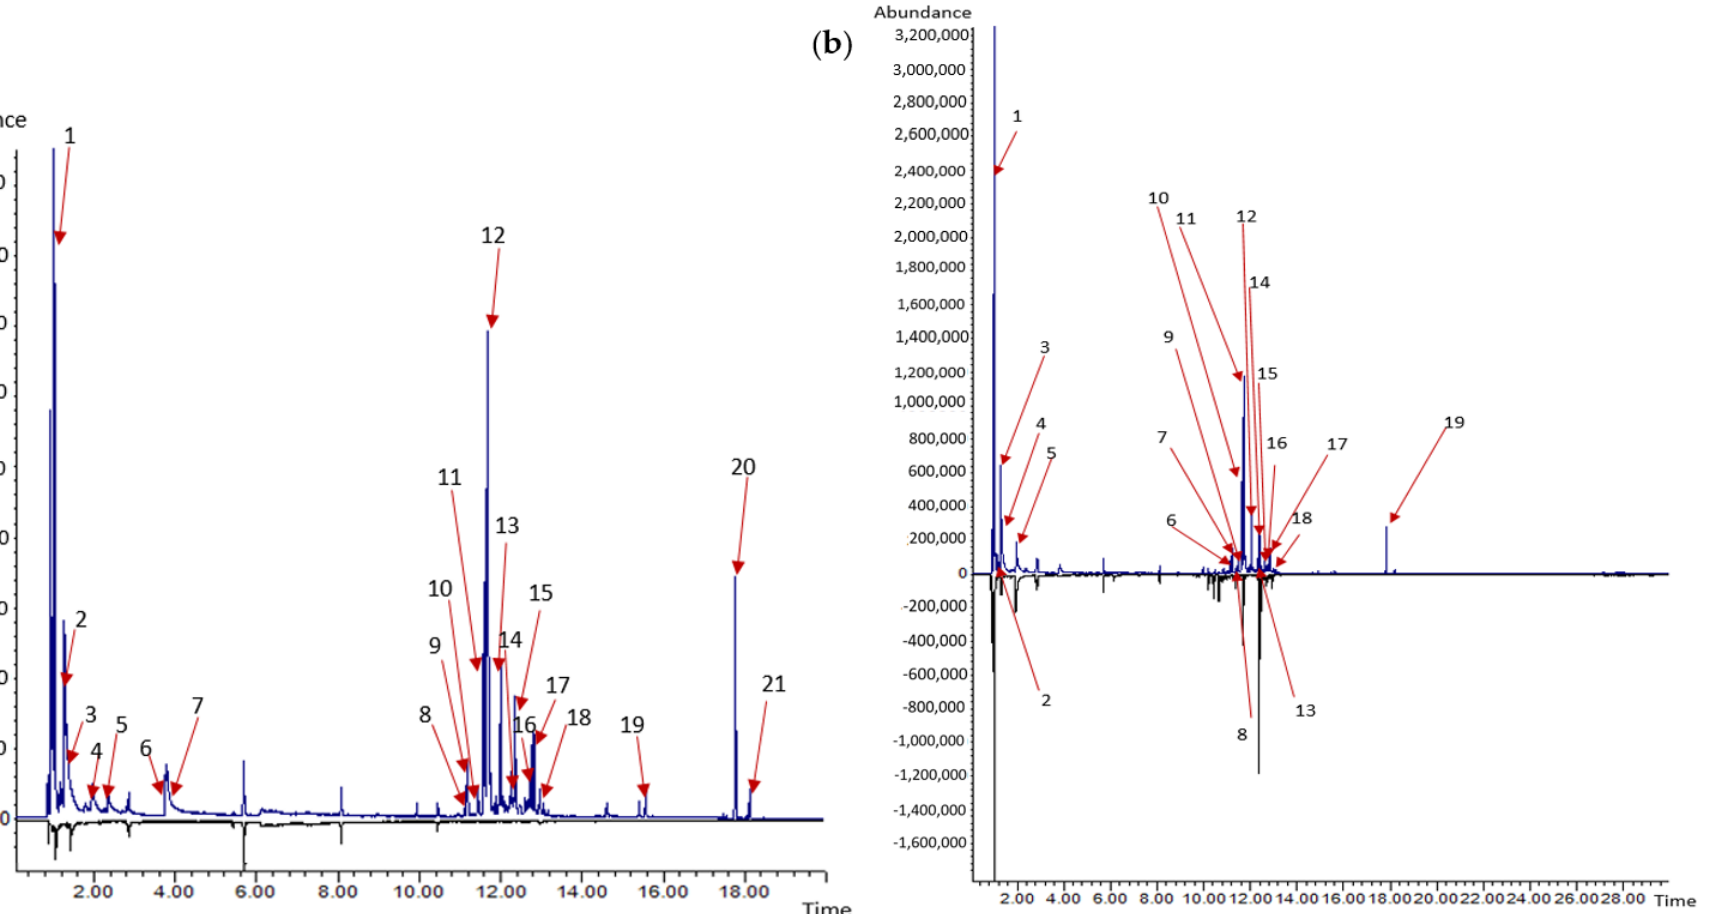
Figure 4. Overlay plot of ( a ) pure culture of strain #5001 on top and media control at bottom; ( b ) co − culture of strain #5001 with P. noxium on top and pure culture of P. noxium strain at bottom. Numbers refer to compounds listed in Table 2.